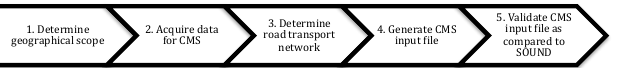
Figure 4. Development Process of Abu Dhabi’s Base Traffic Simulation